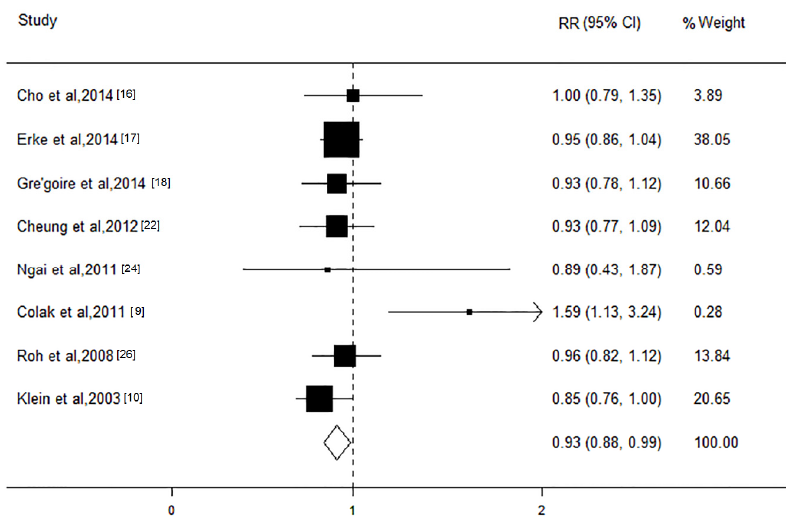
Figure 3. Forest plot on the associations between the low-density lipoprotein level and age-related macular degeneration. The boxes and lines indicate the relative risks (RRs) and their 95% confidence intervals (CIs) on a log scale for each study. The pooled relative risk is represented by a diamond. The size of the black squares indicates the relative weight of each estimate. BDES, the Beaver Dam Eye Study; BMES, the Blue Mountains Eye Study; SMES, Singapore Malay Eye Study; SIES, Singapore Indian Eye Study; SCES, Singapore Chinese Eye Study.